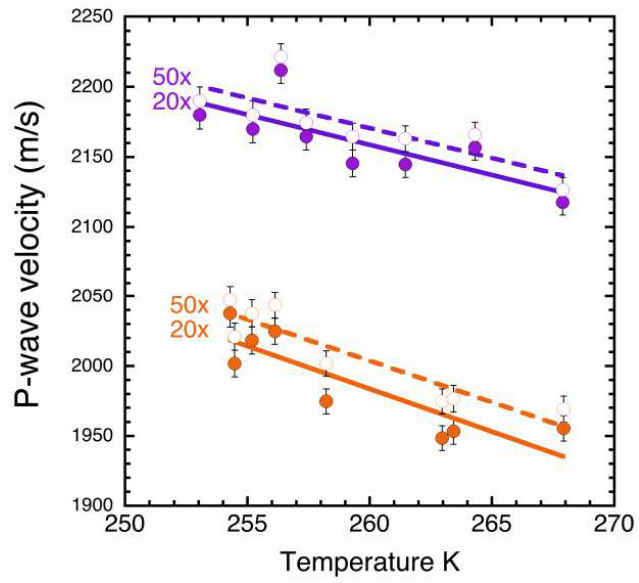
Figure 5. P-wave velocities (at 54 kHz) at two compositions (2.0 and 2.7 wt%NH 3 , as in Figure 4), demonstrating the systematic effect of gain setting on the measurements. The error bars are shown here and described in Section